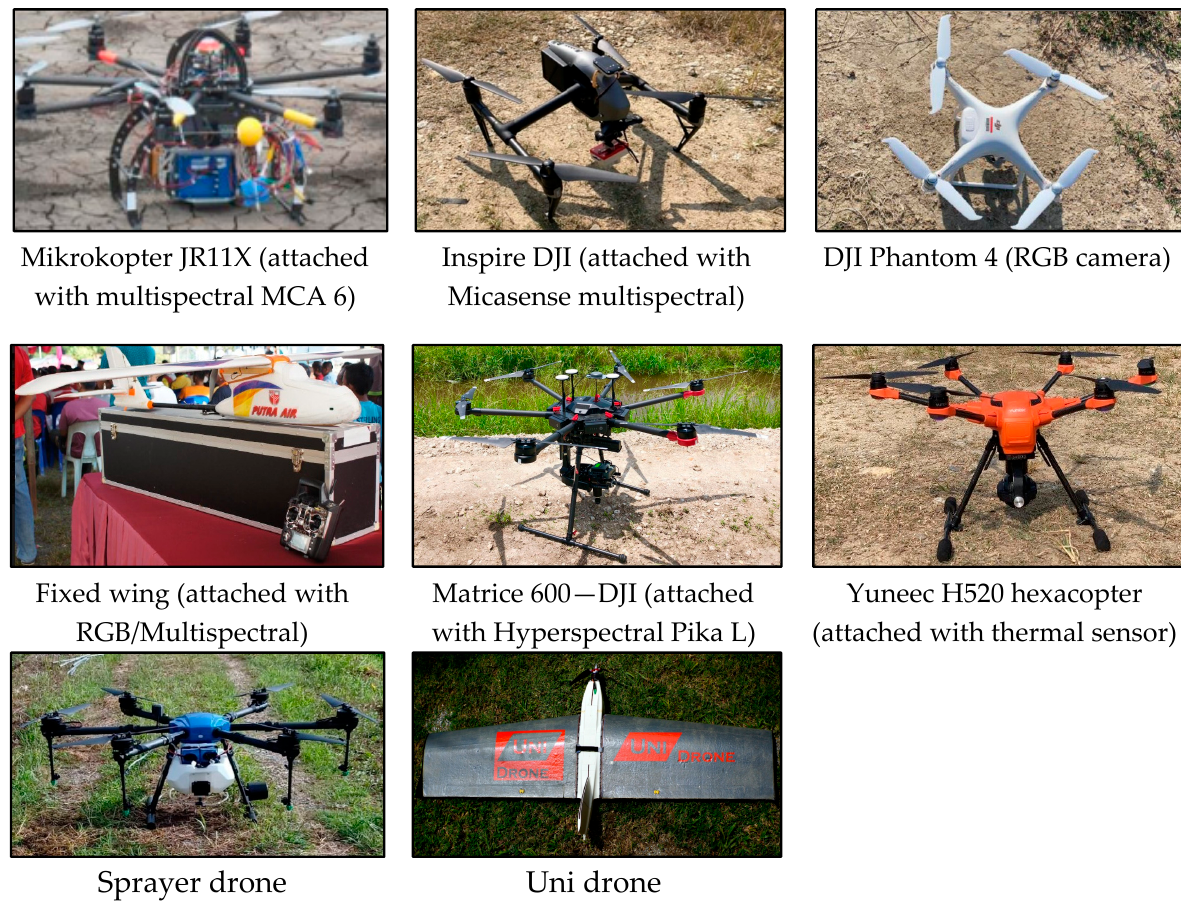
Figure 5. Example of UAV systems used in detecting weed (The pictures were captured by